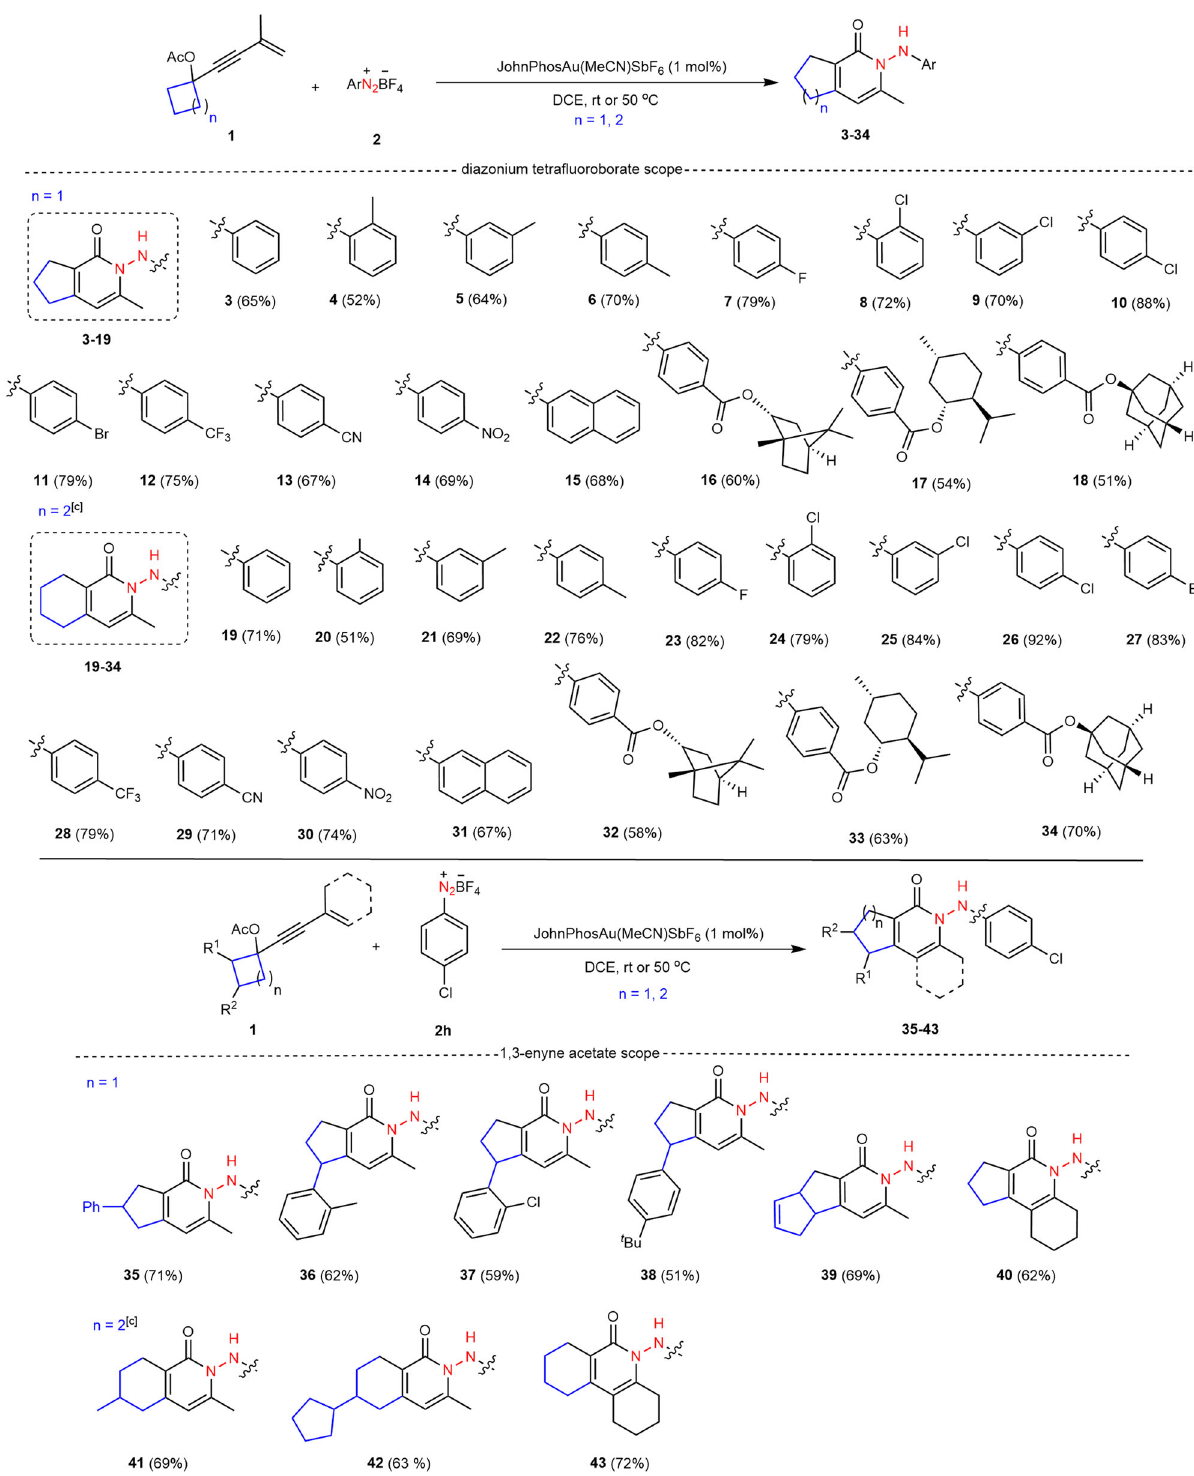
Fig. 2 | Schmidt-type reaction for the synthesis of bicyclic 2-pyridinones. Reaction conditions: 1 (0.2mmol), 2 (0.4mmol), JohnPhosAu(MeCN)SbF 6 (1mol%), DCE (2.0ml), room temperature (rt), 6h; the yield refers to isolated yield based on 1 ; use of cyclopentyl acetate 1 is at